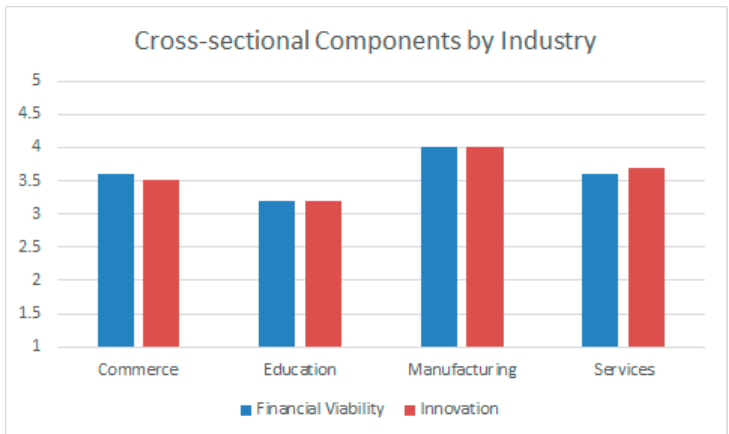
Figure 7. Innovation and financial viability scores by industry.